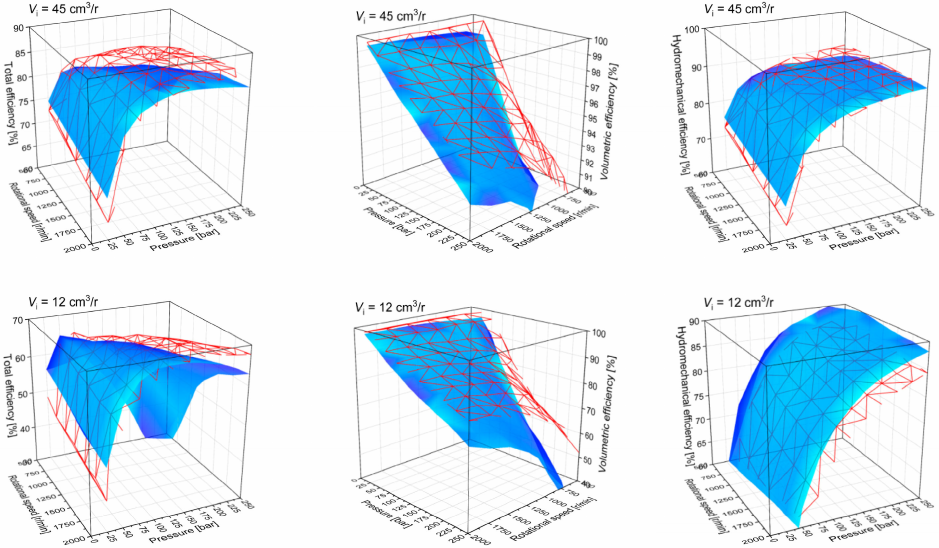
Figure 5. Efficiencies of a variable displacement axial piston pump as a function of pressure and rotational speed with derived capacities of 45 cm 3 /r and 12 cm 3 /r, and with inlet temperatures of 25 ◦ C [ ν = 84 cSt] (red wireframe) and 60 ◦ C [ ν = 21 cSt] (blue surface). Note the varying efficiency